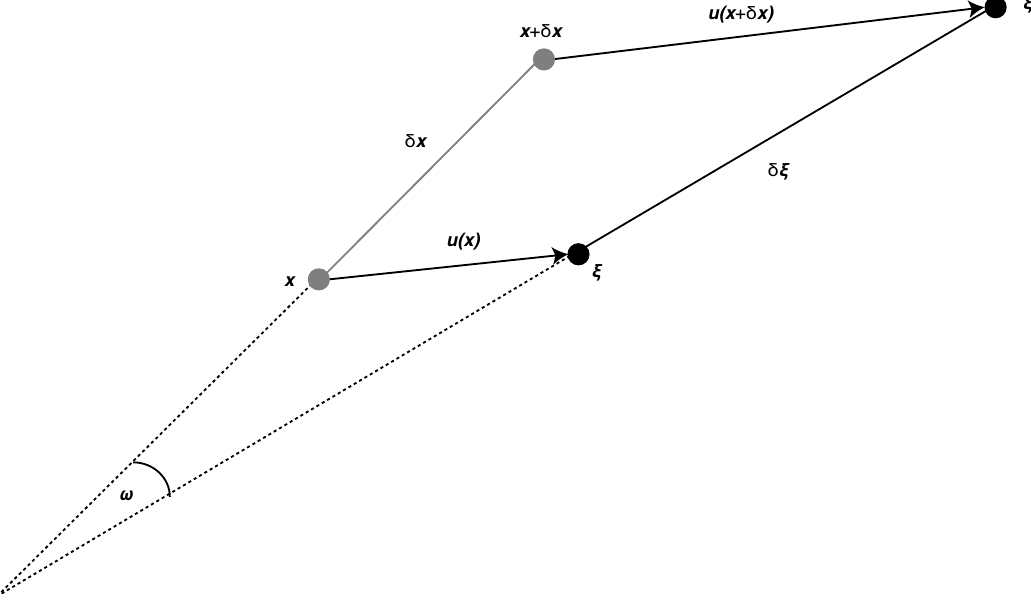
Figure 1. Displacement of a line segment δ x with its end points x and x + δ x in the undeformed state (light gray) being displaced by u ( x ) and u ( x + δ x ) to ξ and ξ + δ ξ in the deformed state, respectively. The total rotation due to the displacement corresponds to the angle ω between δ x and δ ξ modified after Reference